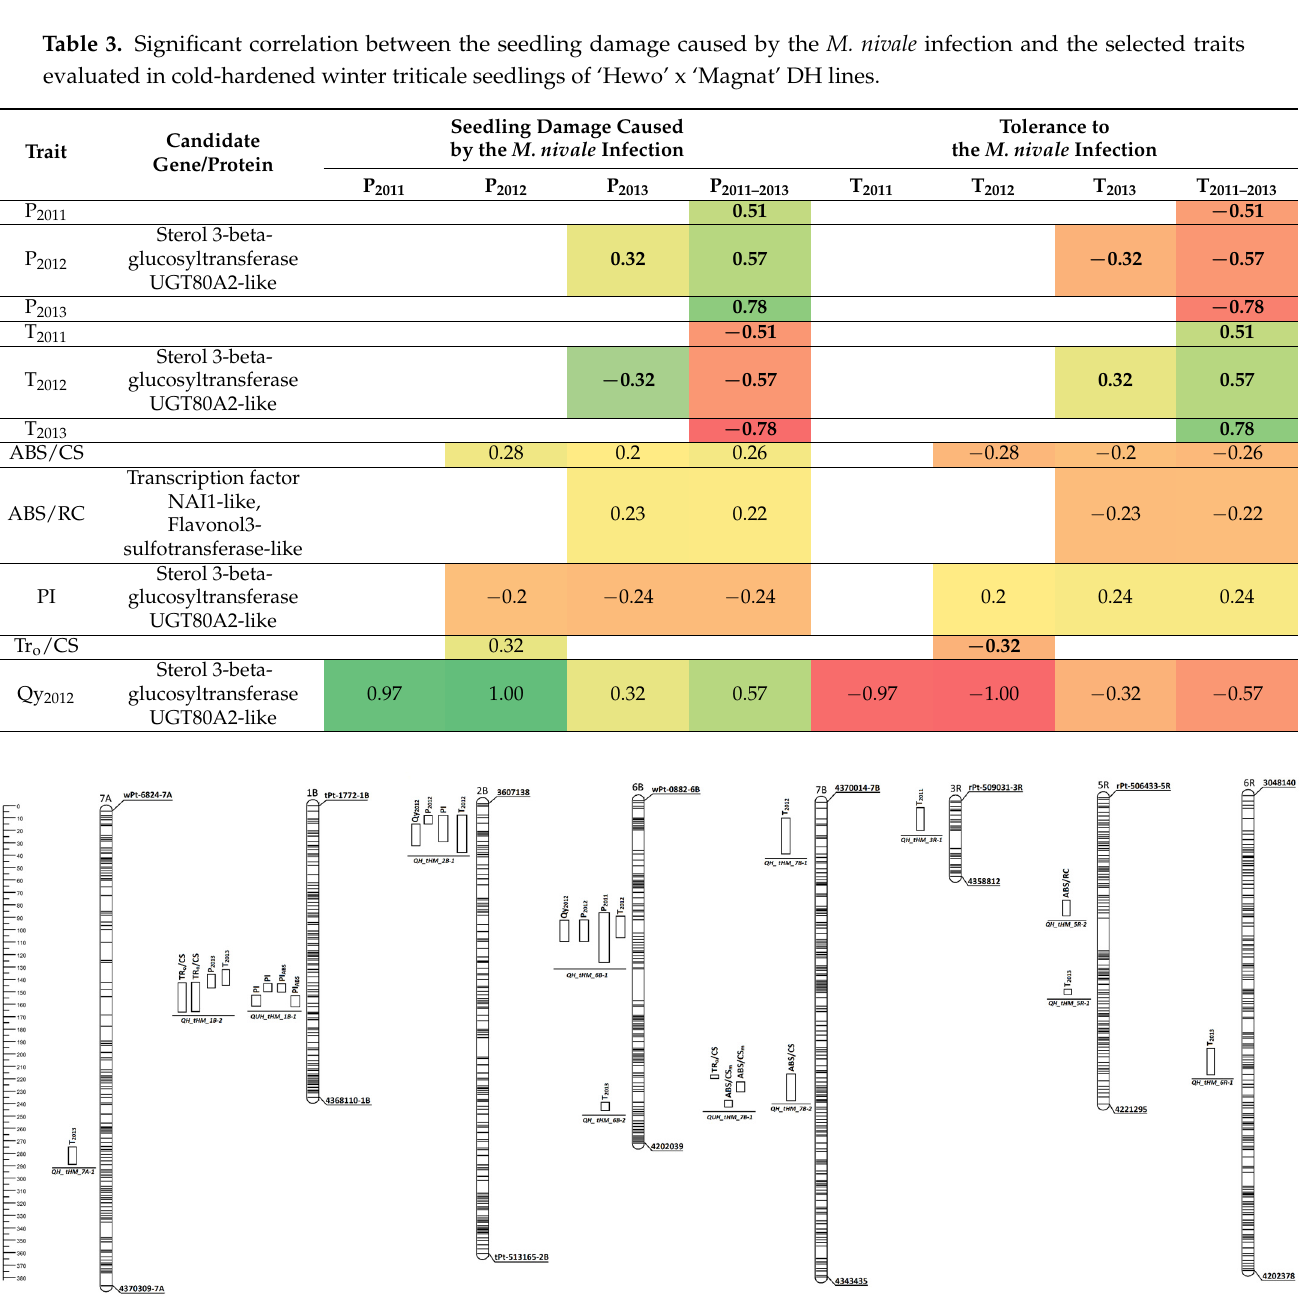
Figure 1. Interval map (cm) for chromosomes 7A, 1B, 2B, 6B, 7B, 3R, 5R, and 6R of ‘Hewo’ x ‘Magnat’ DH lines mapping population of winter triticale (x Triticosecale ) with QTLs associated with: (1) the seedling damage caused by the M. nivale infection (P 2011 , P 2012 , and P 2013 index); (2) the M. nivale infection tolerance (T 2011 , T 2012 , and T 2013 index); (3) photosynthesis quantum efficiency (Qy 2012 ) as well as (4) chlorophyll a fluorescence parameters, identified in unhardened and cold-hardened seedlings. All QTLs were identified by the SMA method. Black lines show markers identified by CIM method.